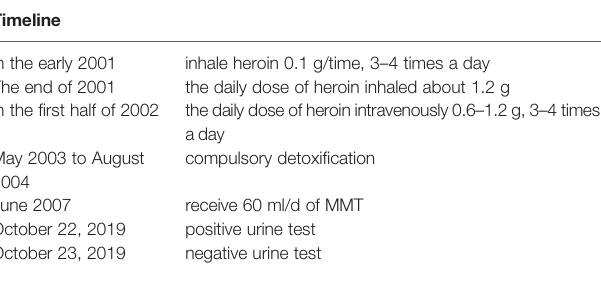
TABLE 1 | Presentation of medication history and medical